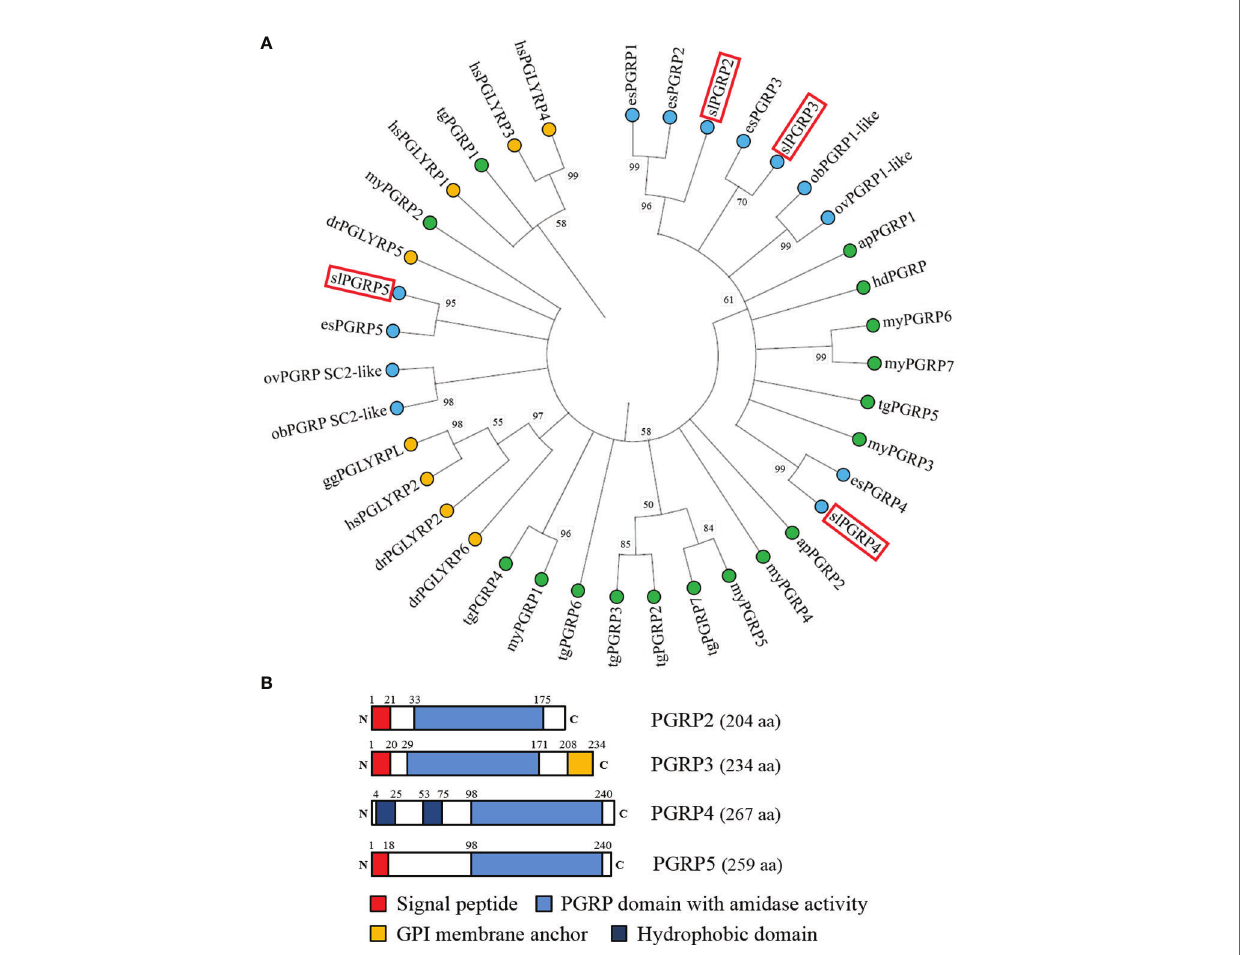
FIGURE 2 | Phylogenetic analysis of PGRP family proteins from various taxa and domain structure of PGRPs in the big fi n reef squid. (A) The phylogenetic analysis of PGRPs in various species. The PGRP domain (with amidase) was used for analysis. The number at each node represents the bootstrap probability (% of 1000 replicates). Branches correspond to values of 50% and higher. The PGRPs of big fi n reef squid ( sl PGRP2, sl PGRP3, sl PGRP4, and sl PGRP5) are indicated by red boxes. The PGRPs from vertebrates, bivalves and gastropoda, and cephalopods are highlighted in yellow, green and blue circles, respectively. The gene names and accession numbers are listed in Table S2 . (B) The predicted structure of sl PGRPs in the big fi n reef squid. Red denotes the signal peptide. Blue denotes PGRP domain with amidase activity. Yellow denotes glycosylphosphatidylinositol (GPI) membrane anchor. Indigo denotes hydrophobic domain (predicted transmembrane